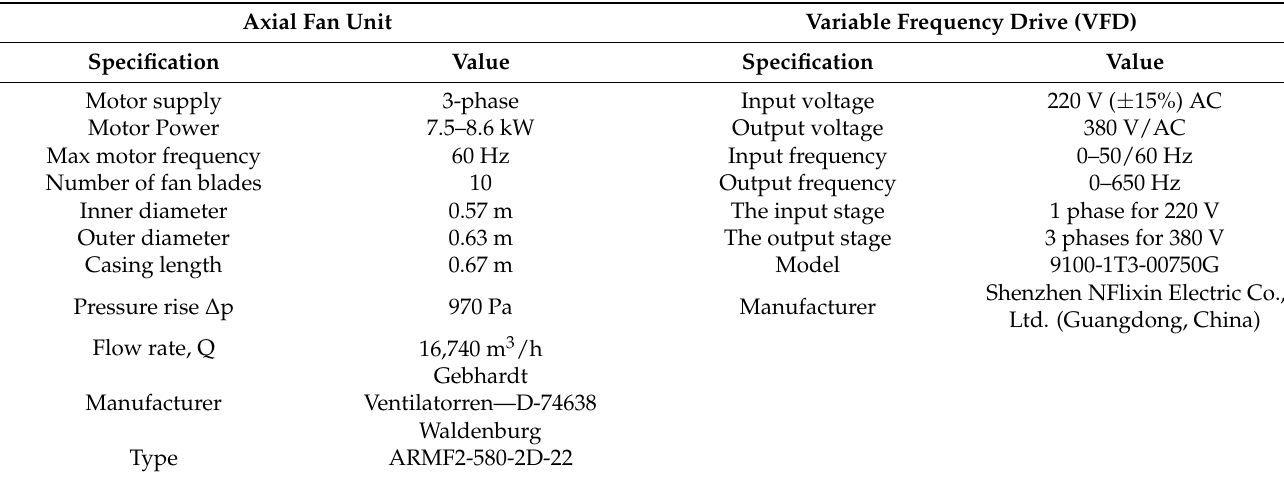
Figure 1. A typical image of the assembled small low-speed open-circuit blower wind tunnel. Table 1. Specifications of the axial fan unit and variable frequency drive (VFD).